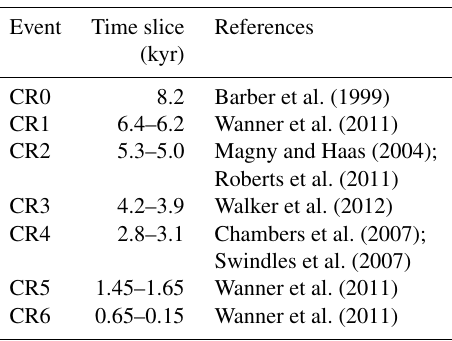
Table 1. Chronology of Holocene cold relapses (CRs) based on ex- isting